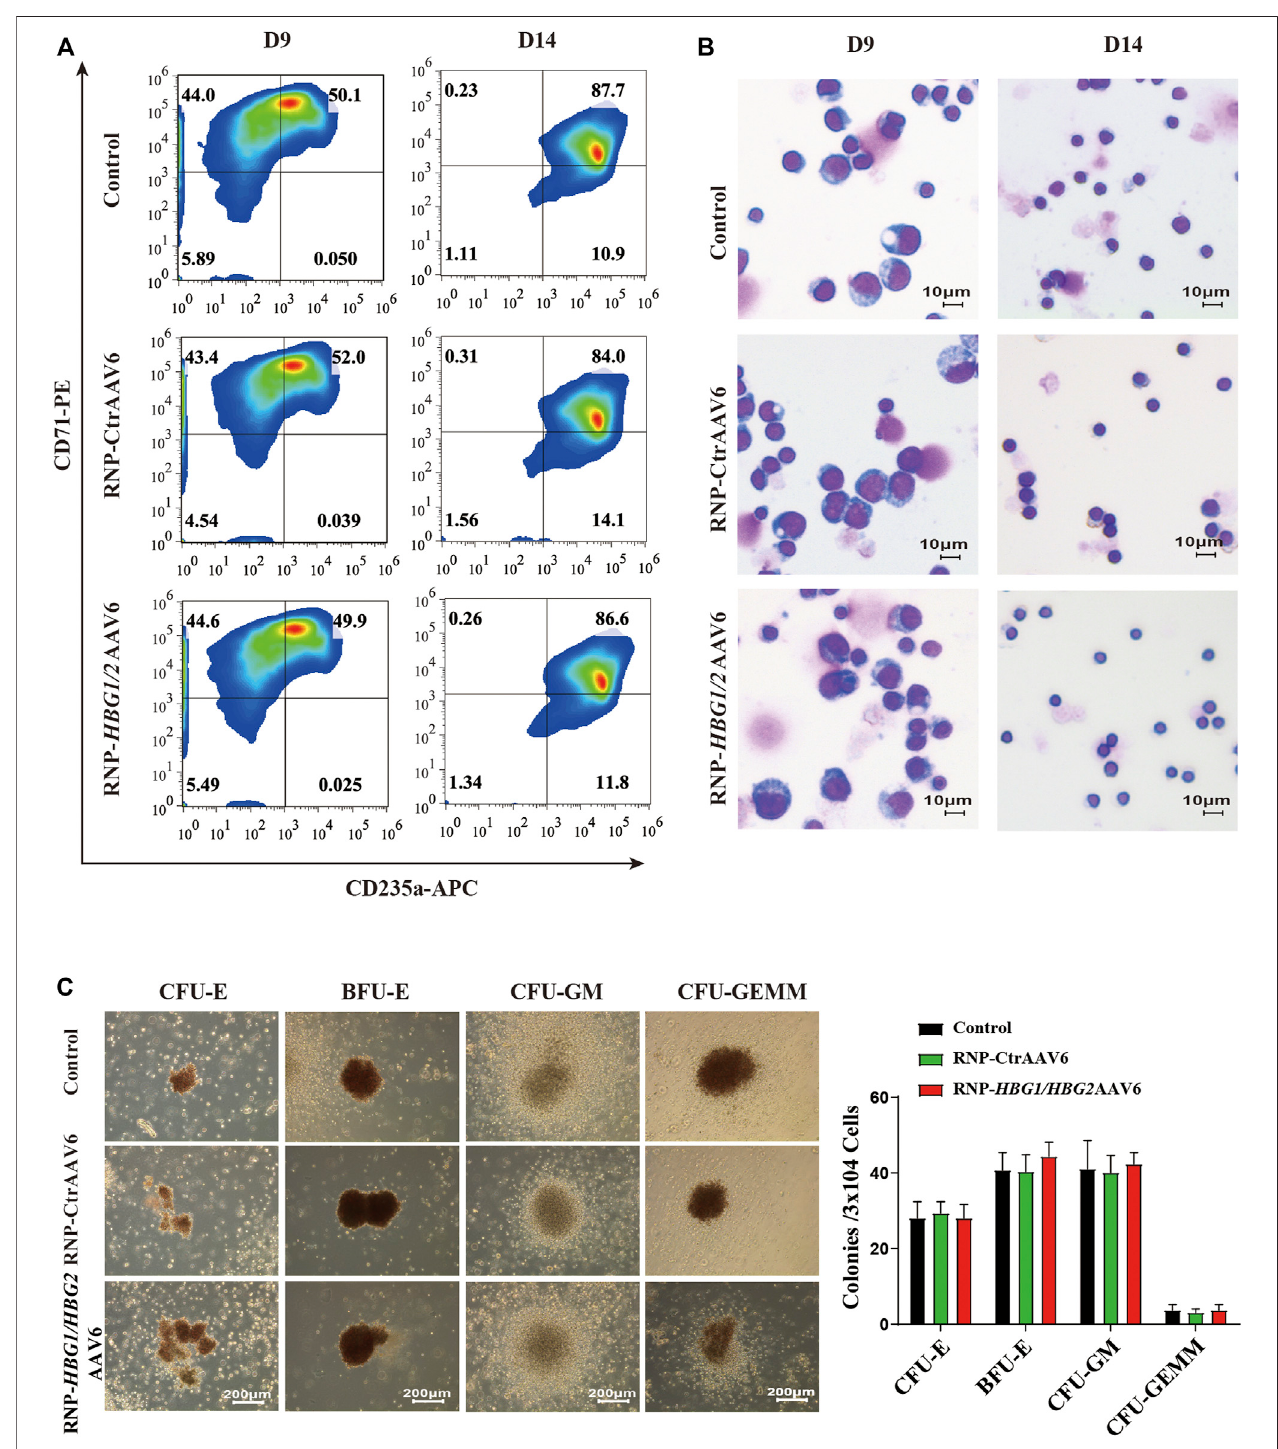
FIGURE3| TheimpactofthegenomeeditingstrategyonthedifferentiationofCD34 + HSPCs. (A) Erythroiddifferentiationwasmeasuredonindicateddaysby fl ow cytometricanalysisbasedontheexpressionofCD235aandCD71.Thedatare fl ectstudiesofCD34 + cellsfrom β -thalassemiadonorsinthreeindependentexperiments, the representative plots are shown. (B) Representative images of Wright-Giemsa staining of different time points of differentiated CD34 + cells (objective lens, ×40). (C) Left:morphologyofcoloniesat14 daysculturewereobservedatamagni fi cationof×40.Right:colonieswerecountedandclassi fi edaccordingtotheirmorphology (mean ± SD, n =